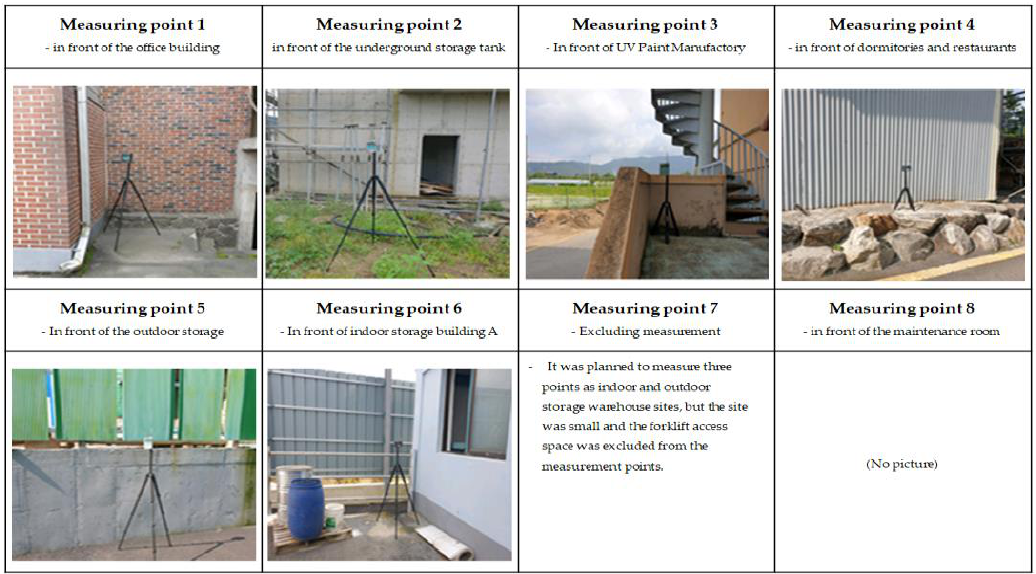
Figure 6. Installation of measurement equipment for research target study site B.